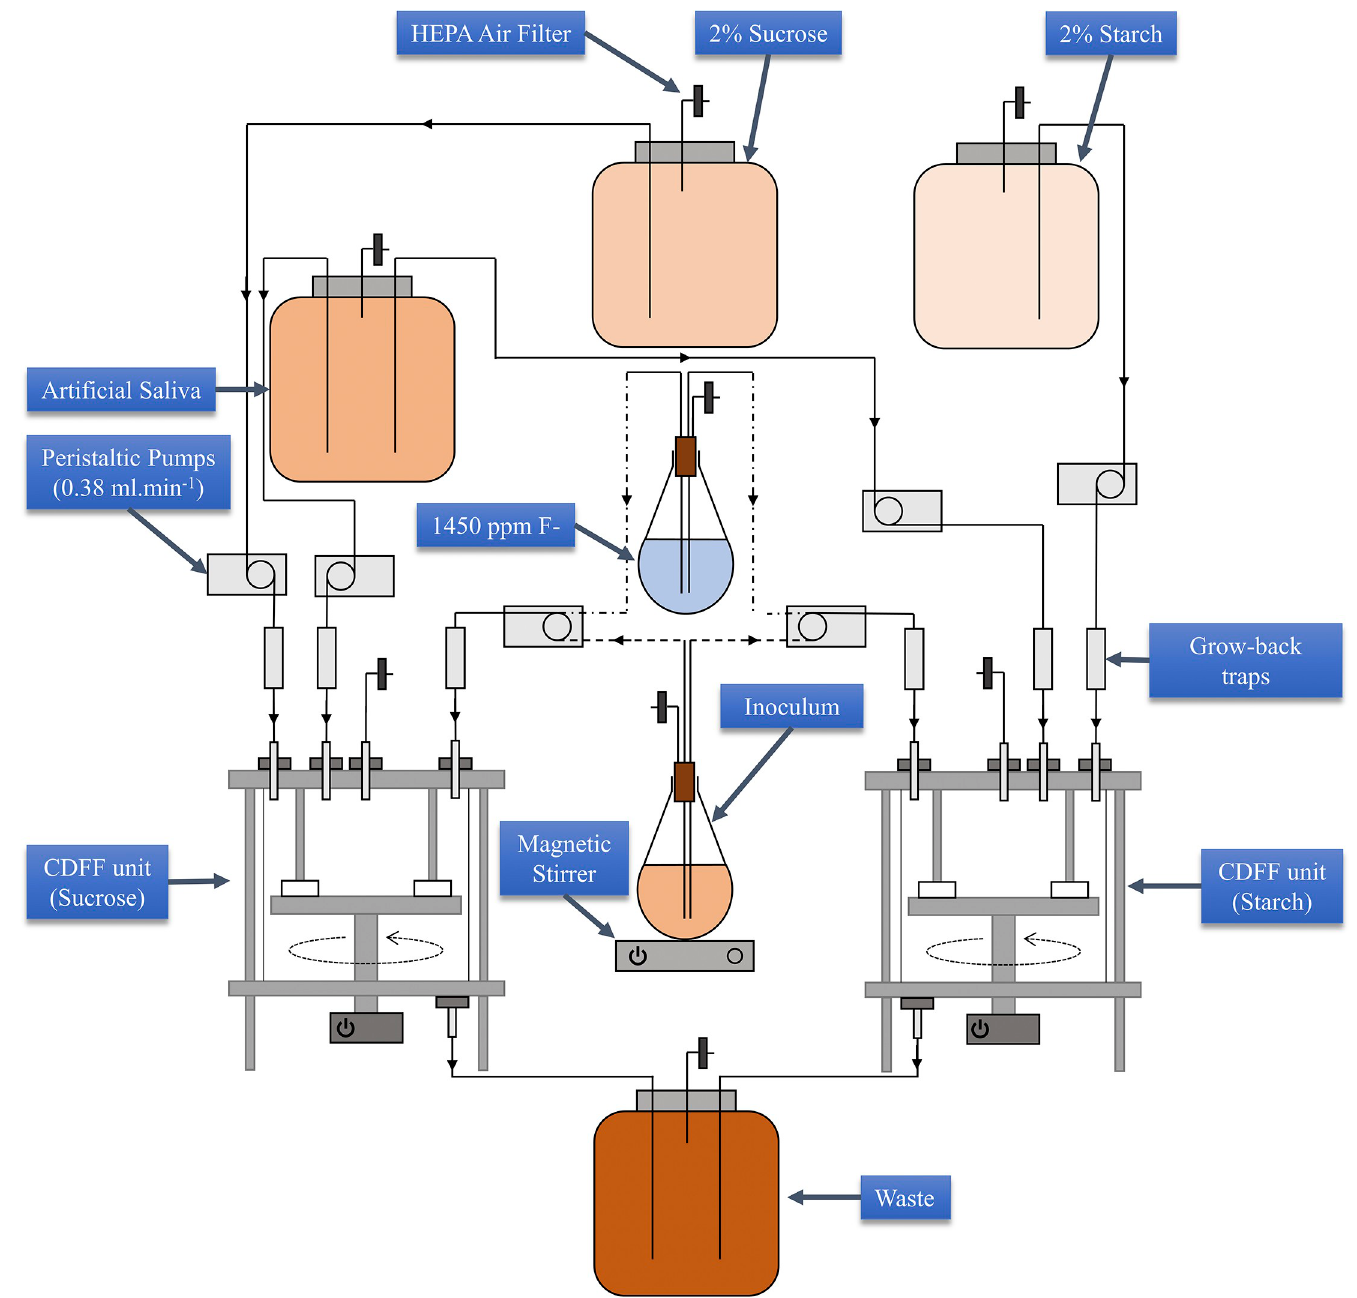
Fig 1. dCDFF schematic. The dCDFF was setup as shown. Each peristaltic pump was set to 0.38 ml.min -1 for all media into the CDFF units. All inputs incorporated a grow-back trap to prevent a cross contamination. The source of 1450 ppm F- was only used for experiment 2, all other components were the same for both experiments. https://doi.org/10.1371/journal.pone.0258881.g001 the timed sources of sucrose and starch began. The carbohydrate sources were pulsed into the appropriate CDFF unit 8 times daily for 30-minute intervals at a rate of 0.38 ml.min -1 . The 8 daily carbohydrate pulses was chosen as a previous study using 2% sucrose 8 times daily was shown to induce an acidic environment resulting in a loss of mineral from a substrate in S .